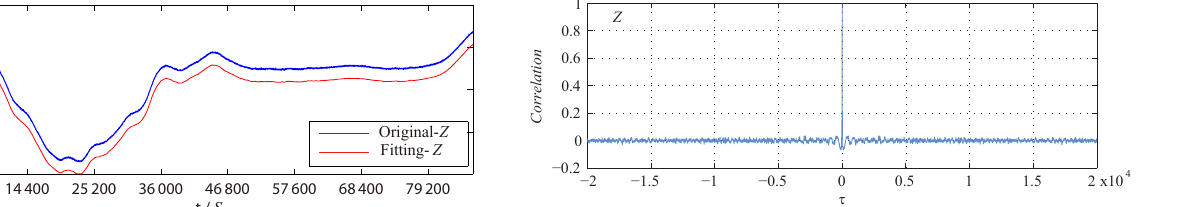
Figure 3. Original signal and fitting data of the Z component.